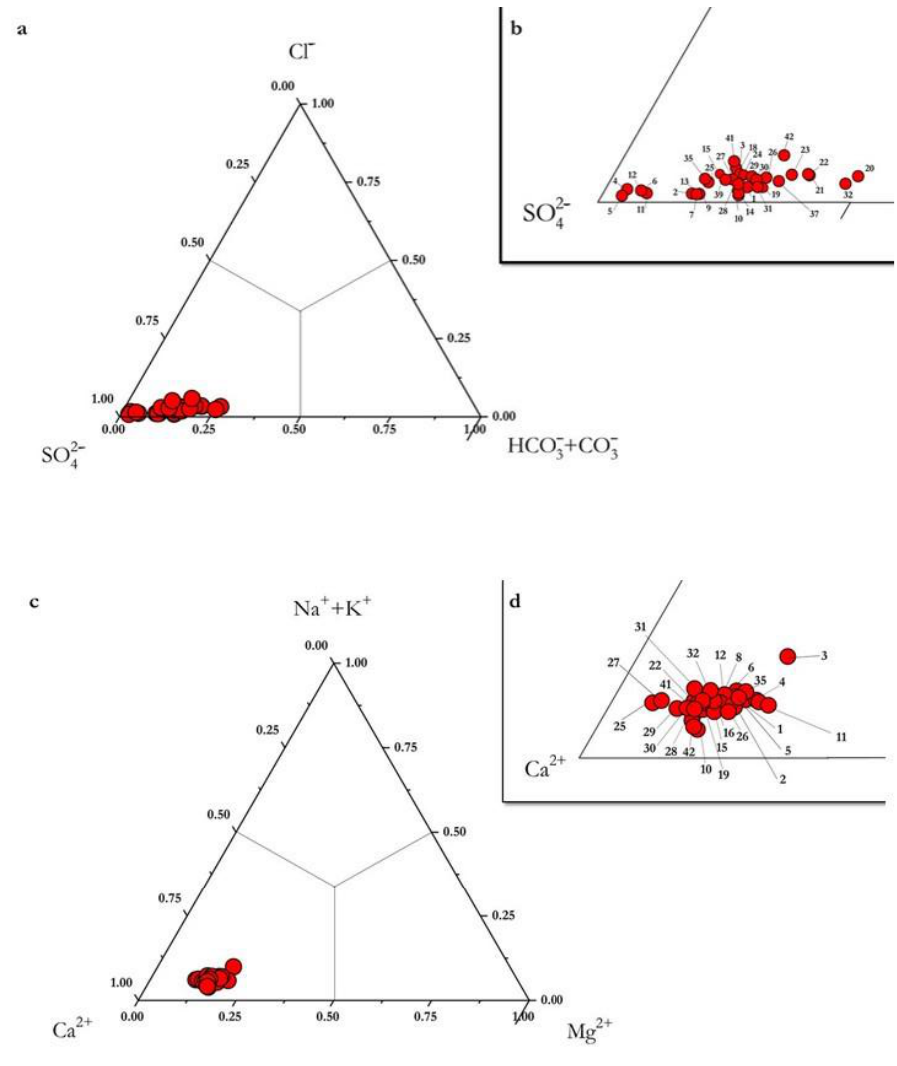
Figure 3. Triangular diagrams of Cl-HCO 3 + CO 3 -SO 4 ( up, diagrams a and b ) and Na + K-Mg-Ca ( down, diagrams c and d ). For each diagram, an inset is included (respectively b and d) to better observe the distribution of the analyzed samples from Galleria Italia. The Identification Numbers (IDs) refer to refer to the different surveys (see Table 1).